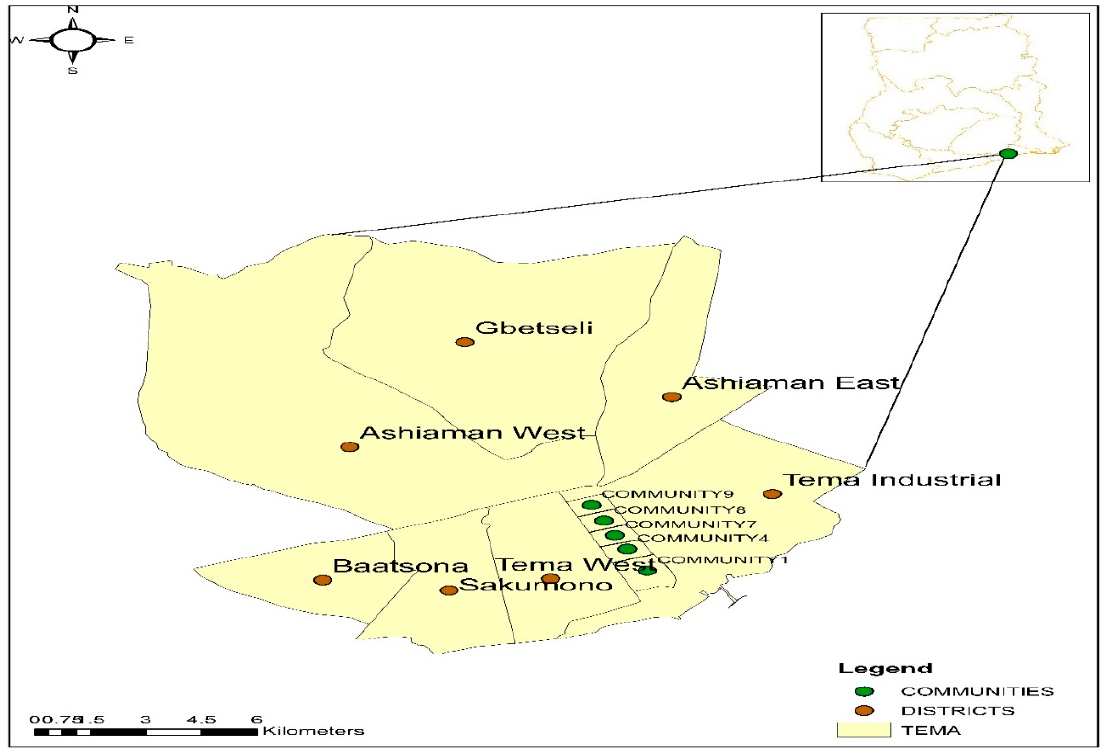
Figure 1. GWCL operational boundaries in Tema showing study communities.